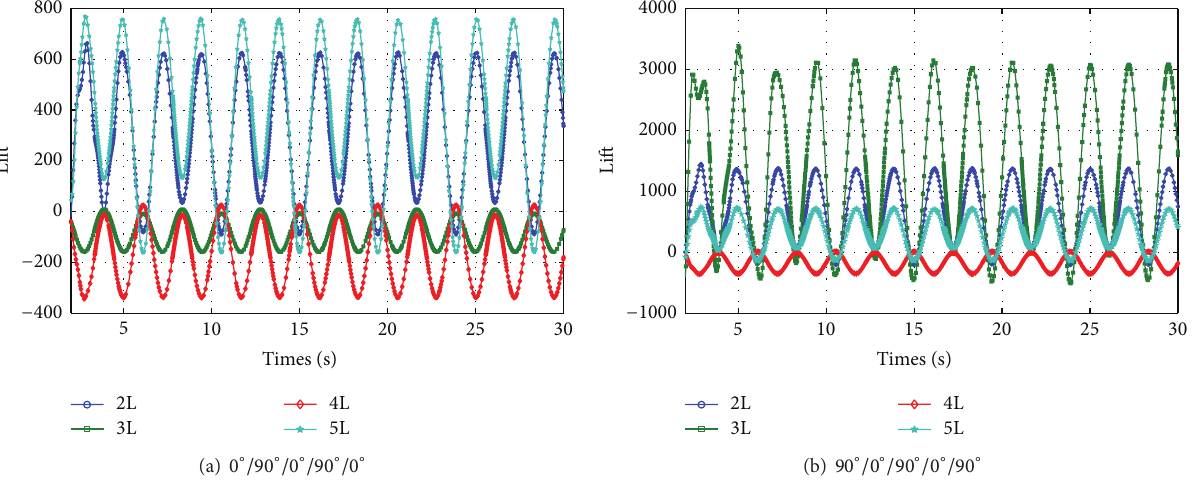
Figure 8: Lift of fin in the case of rotation